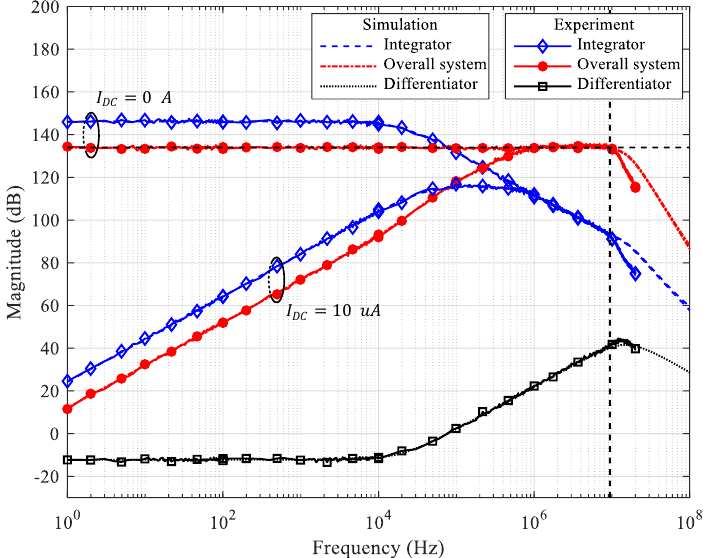
Figure 8. Simulation and Experimental